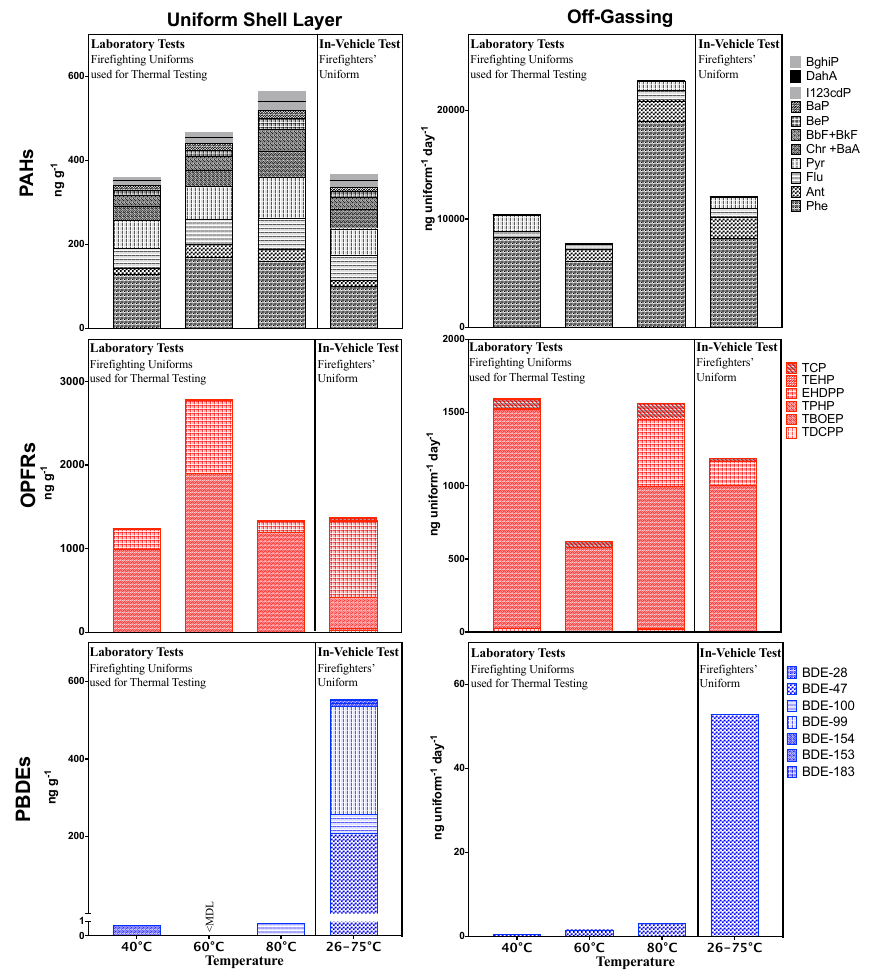
Figure 2. Concentrations of polycyclic aromatic hydrocarbons (PAHs), organophosphate flame retardants (OPFRs), and polybrominated diphenyl ethers (PBDEs) in structural firefighting uniforms (ng g − 1 ) and rate of off-gassing (ng uniform − 1 day − 1 ). (< MDL = 0). The concentrations of ∑ 13 PAHs in the shell layer of uniforms ranged from 360–570 ng g − 1 , Phe and Pyr on average, contributing to 32% and 17% of this, respectively. Concentrations of ∑ 6 OPFRs in the shell layer of uniforms were between 1200–2800 ng g − 1 with the highest concentrations being of TPhP and EHDPP. On average, they contributed 67% and 31% of the measured OPFR concentration, respectively. The only PBDEs in the shell layer of uniforms that had been previously used for thermal testing were BDE-100 and BDE 153 that were detected in different uniforms at 0.92 and 0.72 ng g − 1 , respectively. The concentration of ∑ 7 PBDEs detected in the shell layer of the firefighting uniform used by the active fire service member was 550 ng g − 1 , with BDE-99 and BDE-47 contributing to 51% and 38% of this concentration, respectively.